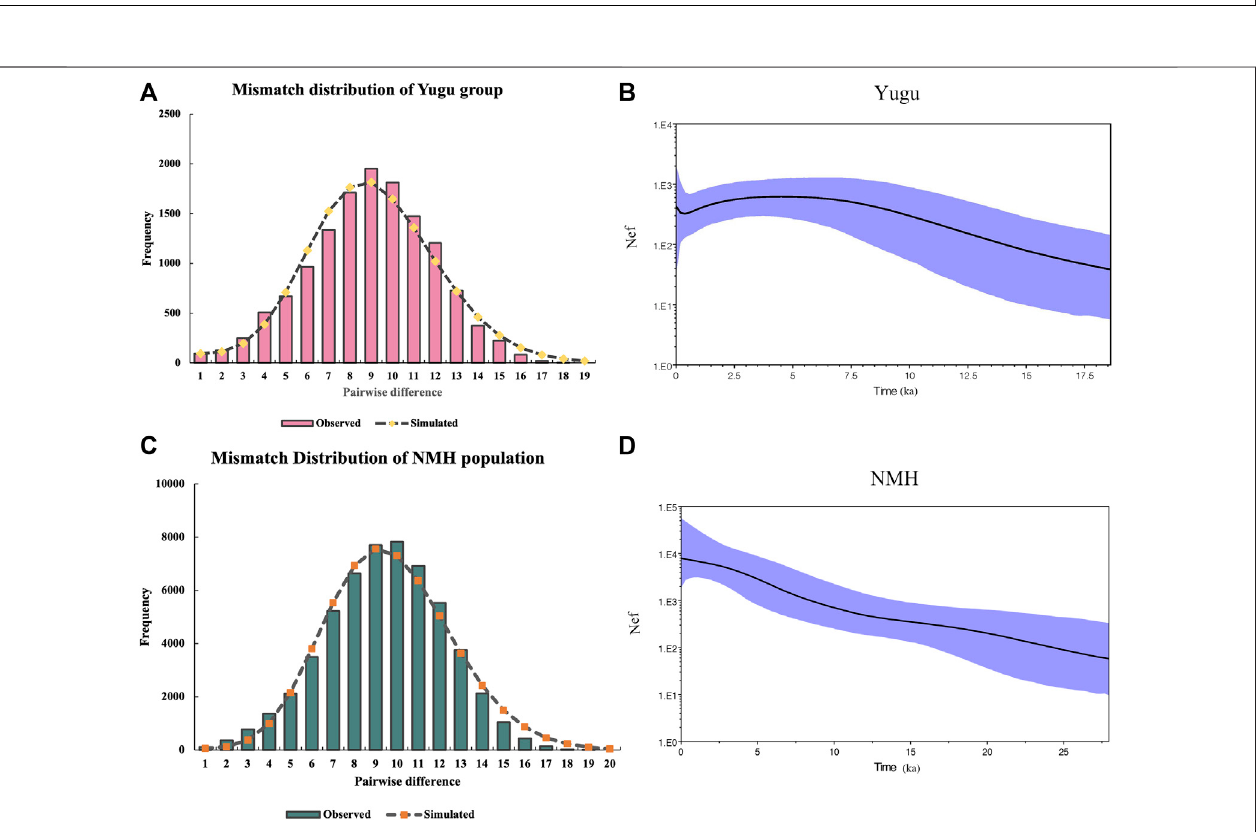
FIGURE 9 | Mismatch distribution and Bayesian skyline plot (BSP) analyses of the Yugu ethnic group (A,B) and NMH population (C,D) . The X -axis of mismatch distributionsindicatepairwisedifferencesbetweentheobservedandsimulatedsequences.The Y -axisofBSPplotsrepresenttheassumedeffectivepopulationsizeona log scale. The blue lines in bold represent the median